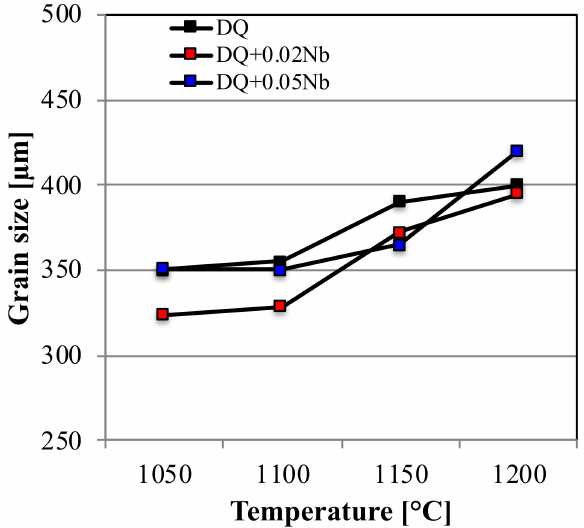
Figure 5. Average prior austenite grain sizes of investigated steels at di ff erent soaking